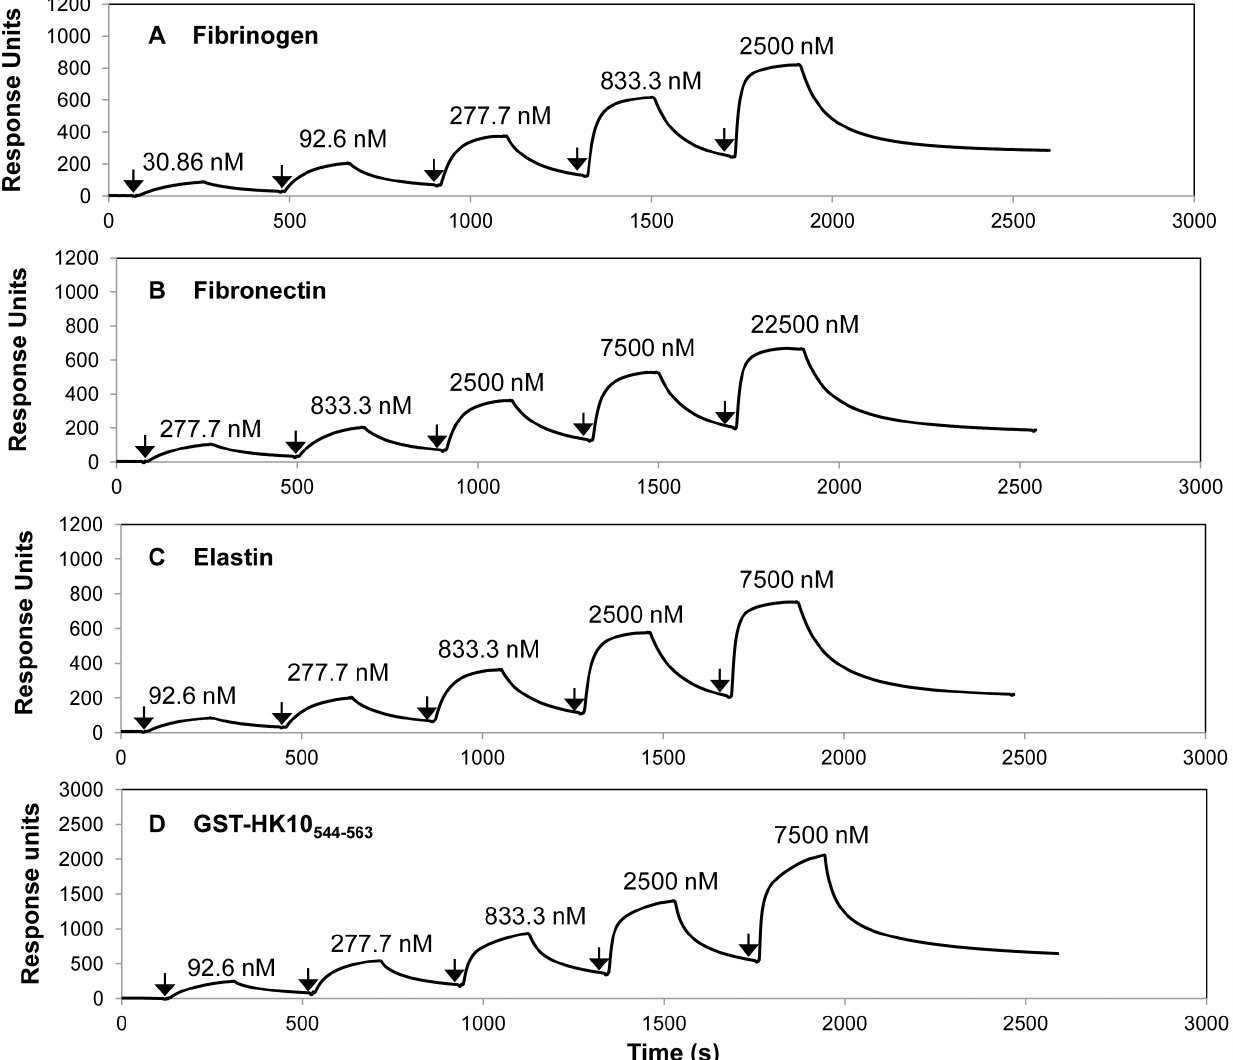
Figure 8. Surface Plasmon Resonance analysis of the interaction of SpsD 167–519 with Fbg, Fn, a -elastin and cytokeratin 10. Human Fbg (A), Fn (B) and a -elastin (C) were immobilized onto the surface of dextran chips. GST-human K10 544–563 , (D) was captured onto a sensor chip coated with goat anti-GST IgG. Representative sensorgrams display binding of SpsD 167–519 to and dissocation from Fbg, Fn, a -elastin and GST-human K10 544– 563 , in a single cycle kinetics assay. Binding was measured as response units (RU) against time. The affinities were calculated from curve fitting to a plot of the RU values against concentrations of SpsD. Arrows indicate the time at which SpsD 167–519 was injected. The data shown is representative of 3 individual experiments.